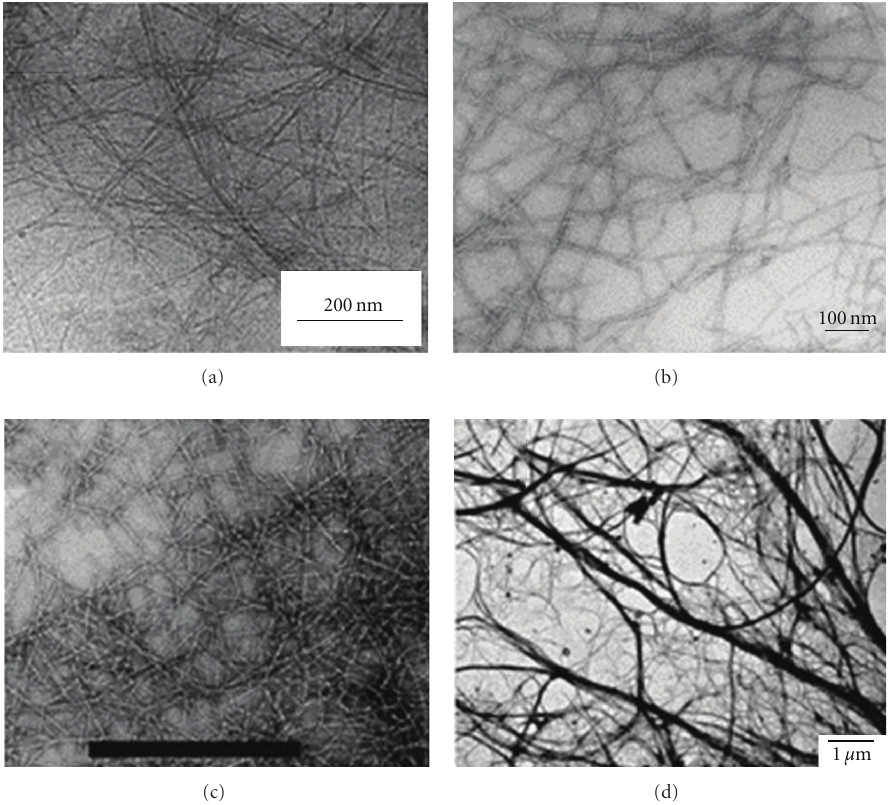
Figure 11: Transmission electron micrographs from dilute suspension of MFC obtained from wood fibers by mechanical processing combined to (a) enzymatic [93], (b) TEMPO-mediated oxidation [94], (c) carboxylmethylation pretreatment [95], and (d) extracted from Opuntia ficus-indica